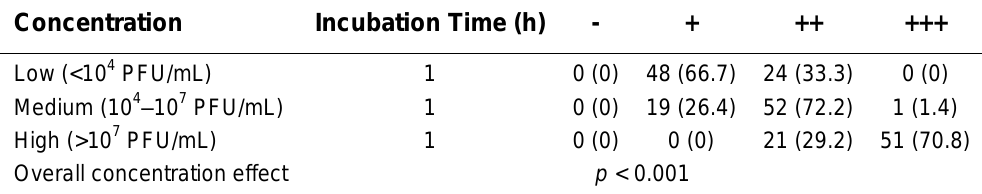
Antibacterial Activity of Different Phage Concentrations against